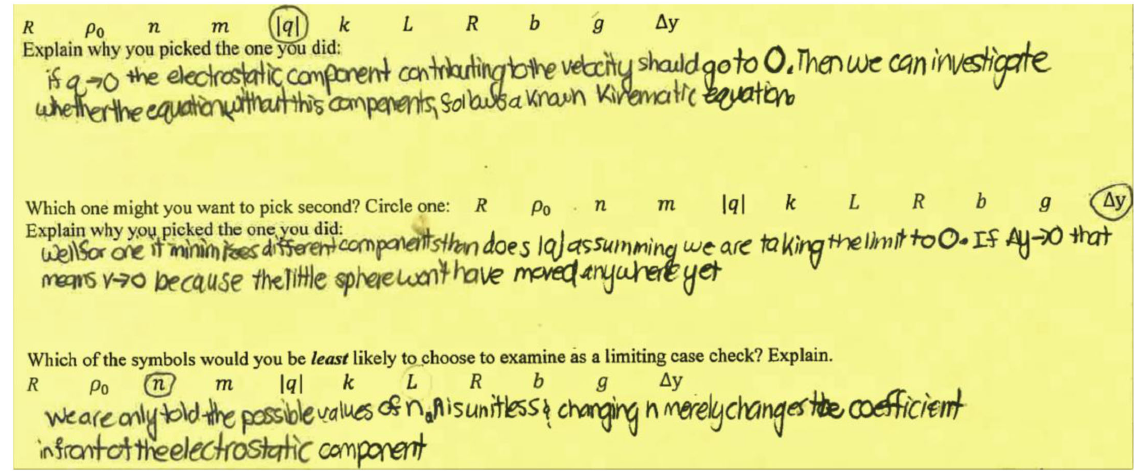
reward.FIG. 2. Student response describing why they picked which variables for LCA. The response indicates a desire to explore variables and cases that may generate interesting or meaningful